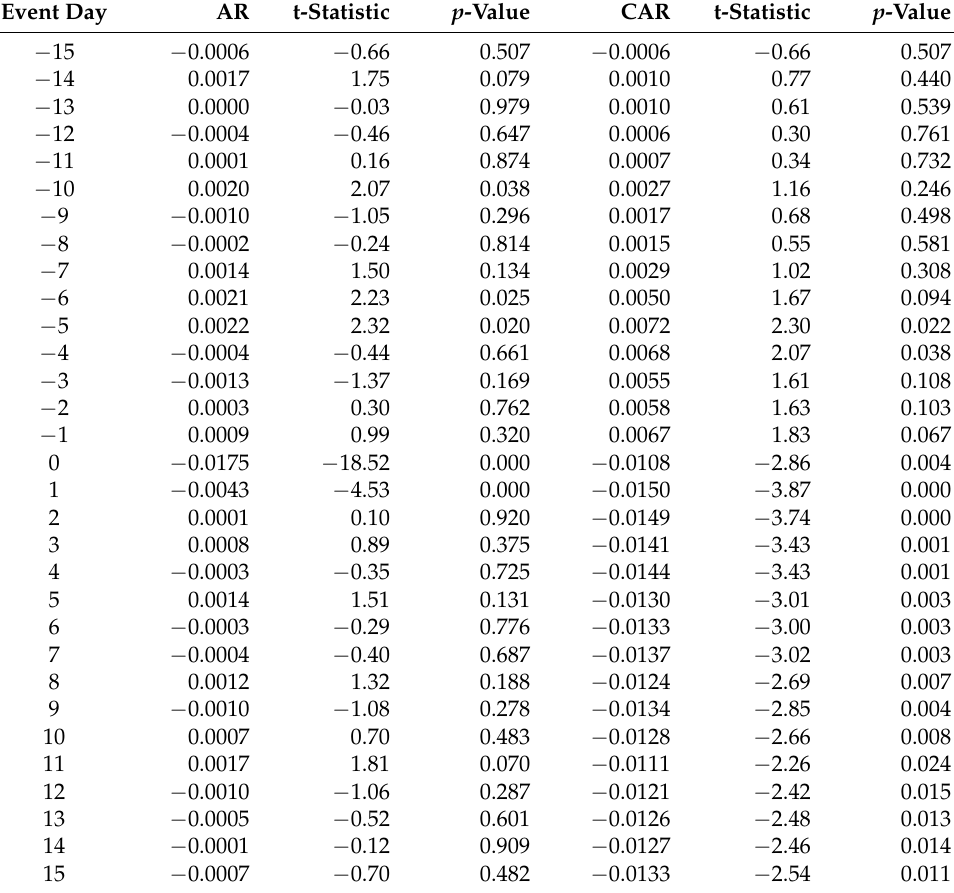
Table A3. Abnormal-return statistics for bad